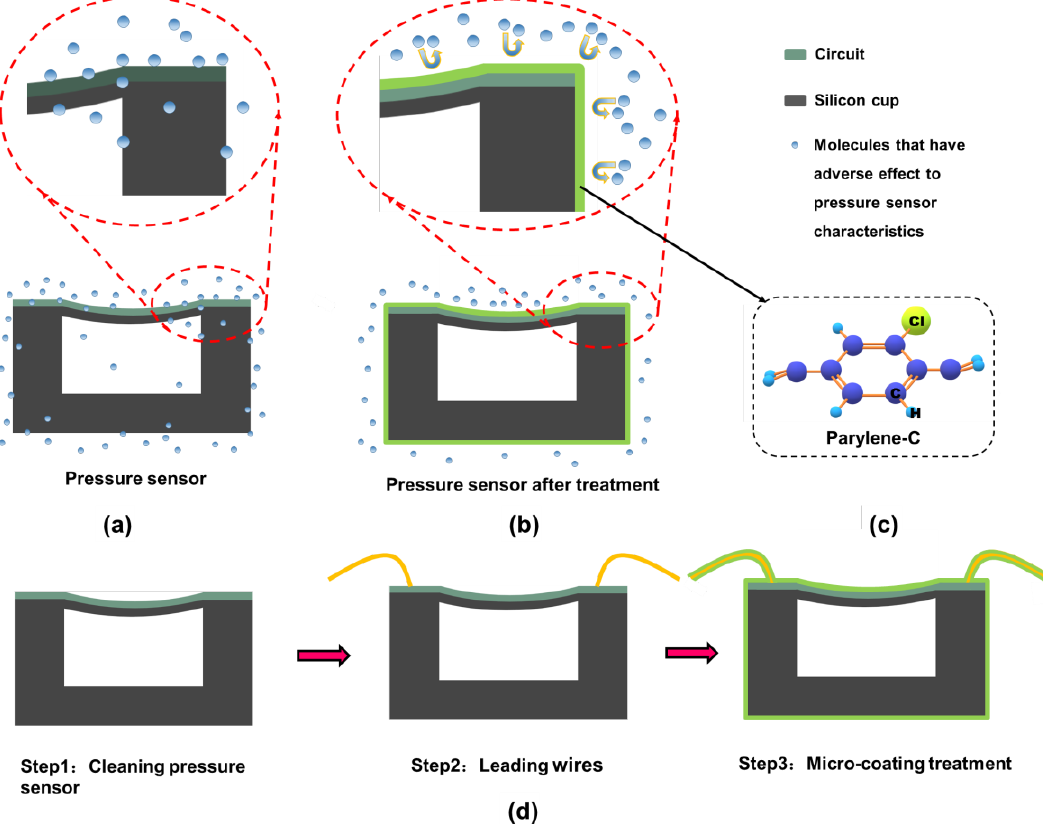
Figure 1. ( a ) A pressure sensor influenced adversely by environmental molecules, affecting the accuracy of the device. ( b ) A pressure sensor with the micro-coating to resist the adverse influence of molecules affecting the accuracy of the device. ( c ) The chemical molecular structure of the micro-coating: parylene-C. ( d ) Three steps of the sensor treatment in this experience.